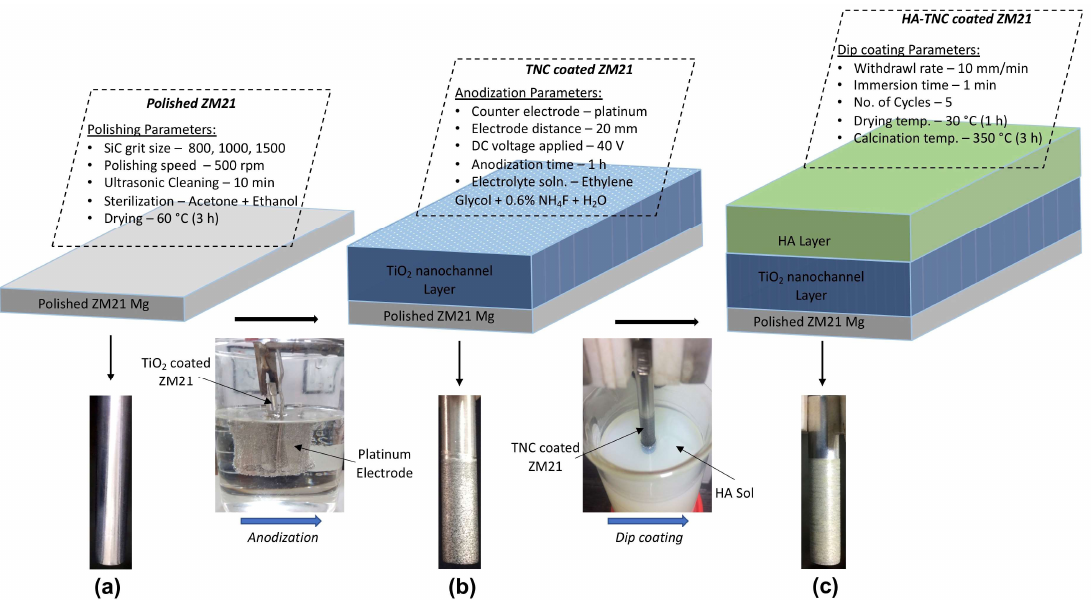
Figure 1. Synthesis route for the preparation of: ( a ) polished ZM21, ( b ) TiO 2 nano-channeled (TNC)- coated ZM21, and ( c ) Hydroxyapatite (HA)-TNC-coated ZM21 samples.